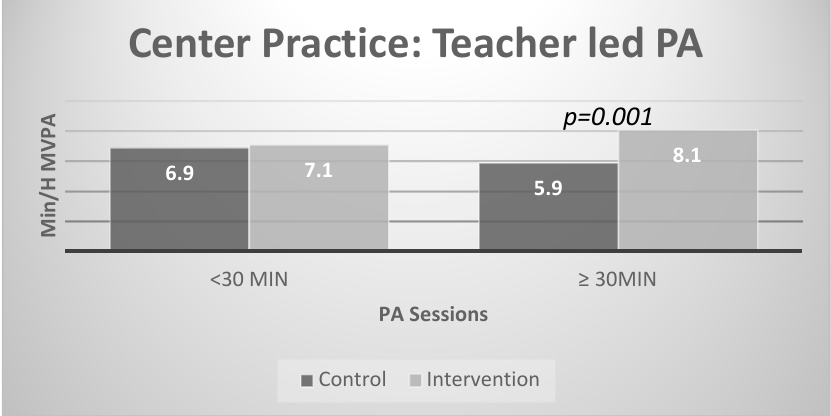
Figure 1. Interaction effects with teacher-led physical activity sessions.